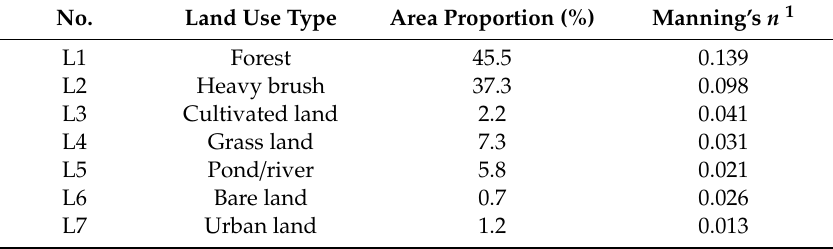
Figure 4. Land use of the Misai basin. Table 1. The proportional area and Manning’s n of di ff erent land use types in the Misai basin. No.